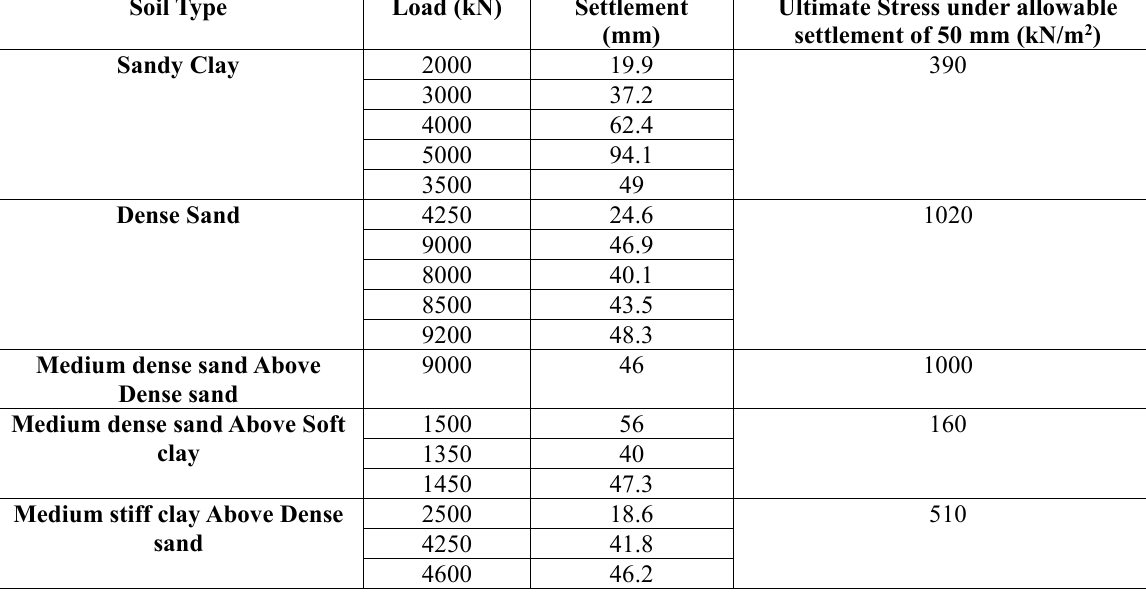
Ultimate stress analysis of footing dimension (3 x 3) for different soil